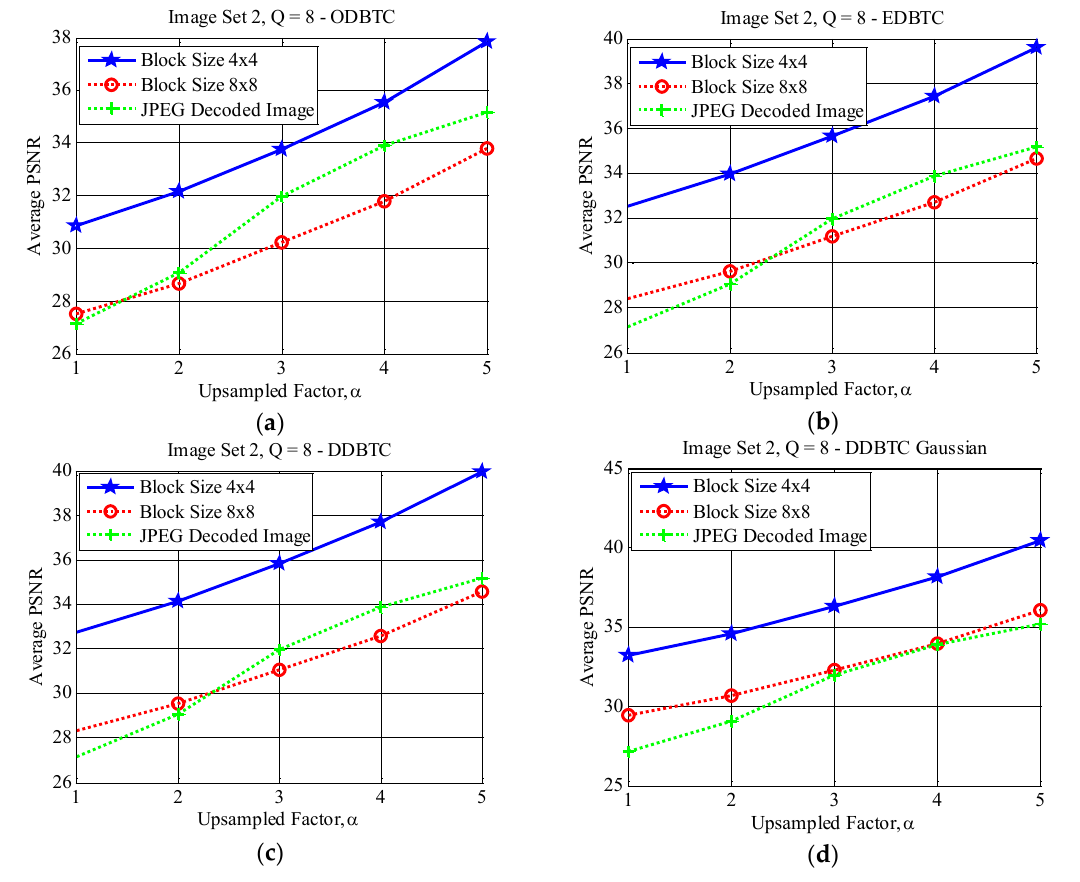
Figure 21. Effect of image block sizes on Image Set 2 with 𝑄 = 8 over ( a ) ODBTC; ( b ) EDBTC; ( c ) DDBTC; and ( d ) DDBTC Gaussian scheme.